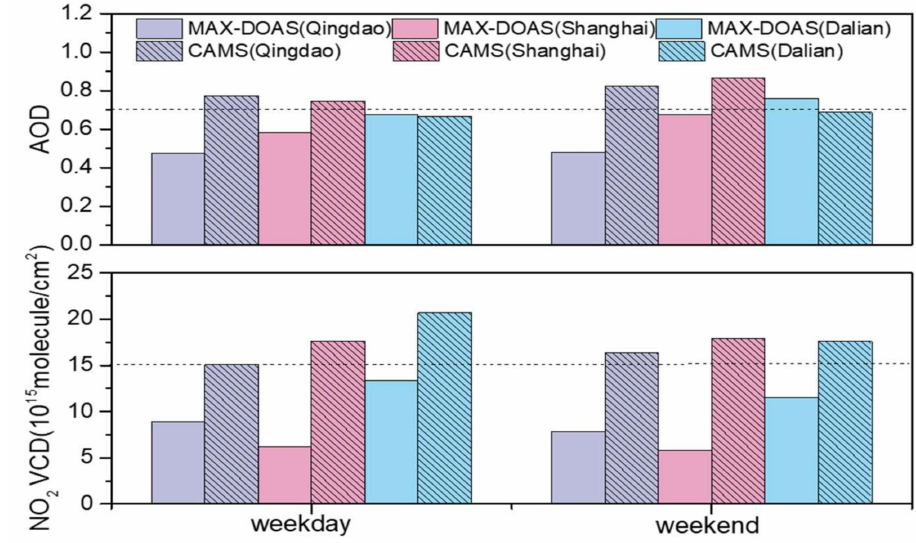
Figure 16. Mean weekly cycles for AOD and NO 2 VCD derived from the CAMS model and MAX- DOAS observations in Qingdao, Shanghai and Dalian.